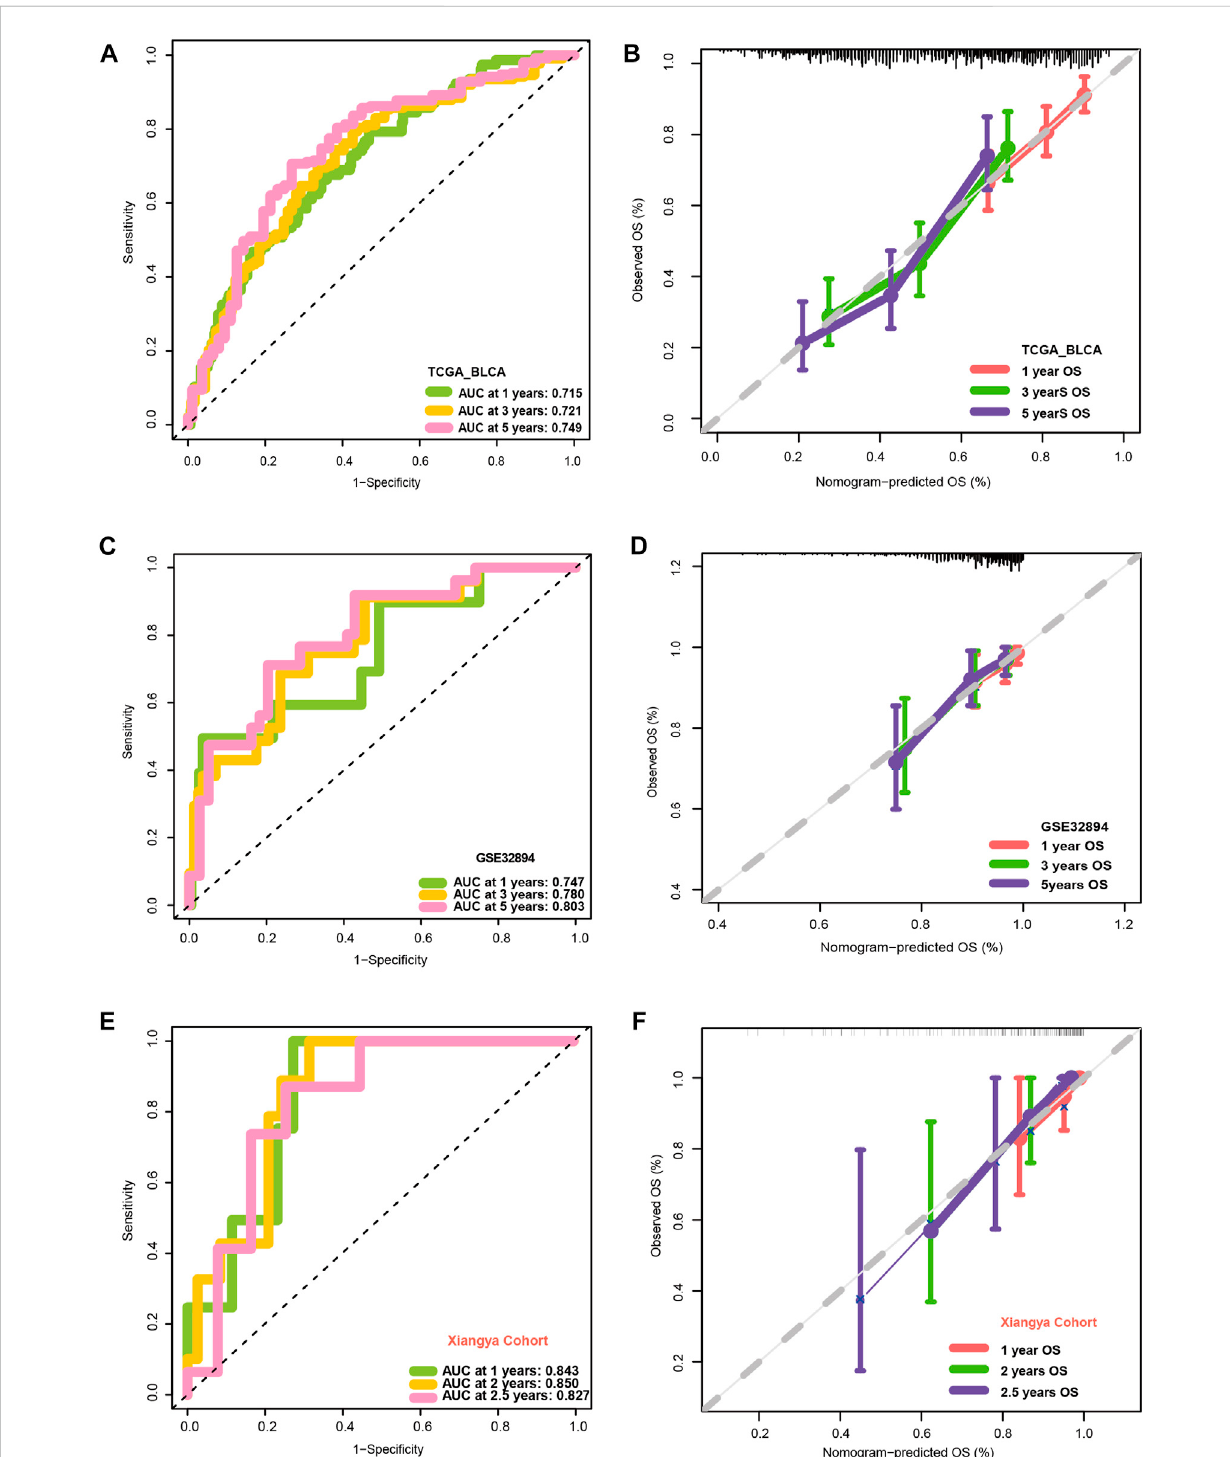
FIGURE 4 Validation of multiple cohorts of VM_Score. (A) ROC curves of the nomogram. (B) Calibration curves of the nomogram measured using the Hosmer – Lemeshow test. (C, D) Validity of VM_Score in GSE32894. (E, F) Validity of VM_Score in Xiangya cohort.